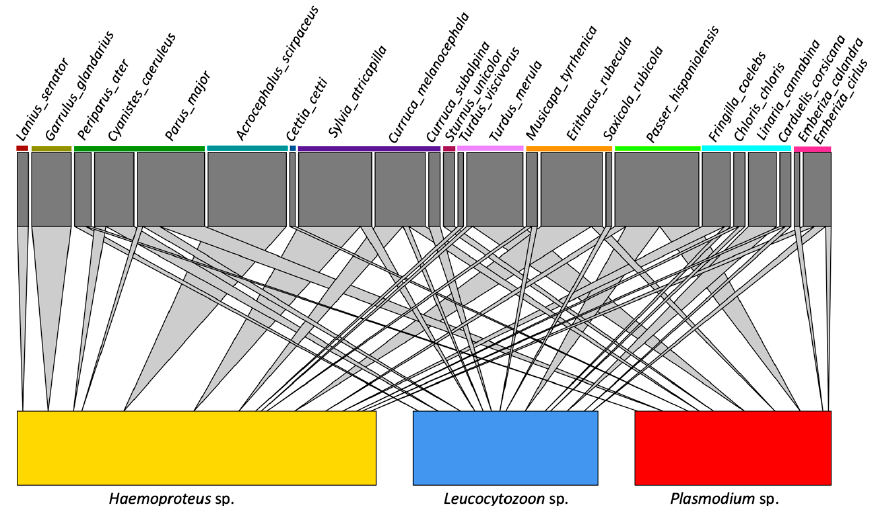
Figure 2. Host-parasite networks of avian and haemosporidian Sardinian communities; parasites were grouped by genus. Interactions between a given host species and a haemosporidian genus is denoted with a cone; the size of the cone is proportional to the number of infections detected in each species. Colored lines under host species names indicate taxonomic family groupings. Diversity 2021 , 13 , x FOR PEER REVIEW